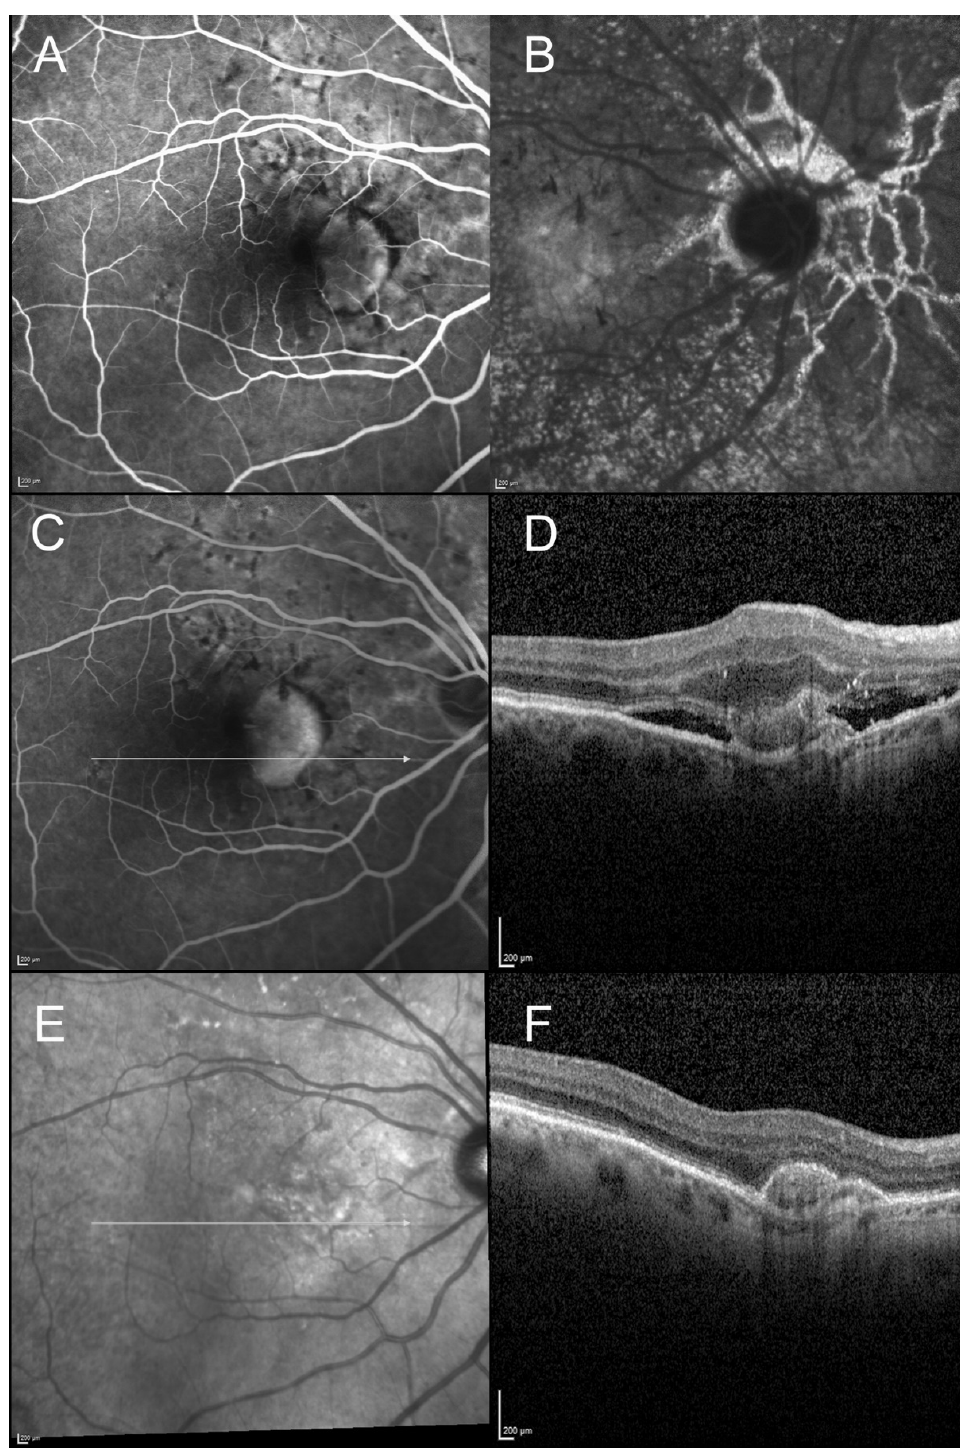
Figure 4. Imaging of a 64-year-old woman diagnosed with angioid streaks, presenting with visual acuity loss. ( A ): Fluorescein angiography (22 s) showing the well demarcated hyperfluorescent type 2 neovascular lesion. ( B ): Indocyanine green angiography (late phase): visualization of the type 2 neovascular lesion is less obvious, but the late phase shows the angioid streaks network clearly. ( C , D ): Fluorescein angiography and horizontal scan of the spectral domain optical coherence tomography (SD-OCT) at baseline. Well demarcated hyperfluorescent type 2 neovascular lesion, with subretinal fluid and hyperreflective exudation observed on SD-OCT. ( E , F ): Infrared reflectance photography and horizontal scan of the SD-OCT, at 1-year follow-up. SD-OCT scan shows the fibrovascular PED without any exudation signs.